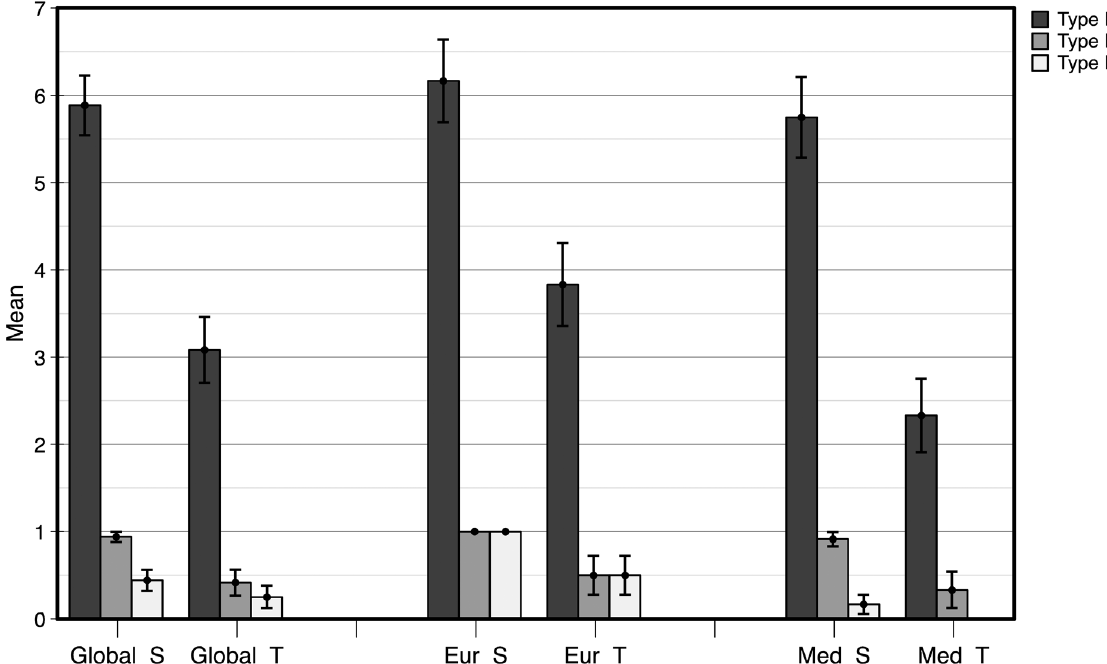
Figure 7. Mean number of species (and corresponding standard error bars) belonging to functional types I, II and III of García-Mora et al. (1999) in type S and type T dune profiles, for the overall dataset (‘Global’), in Eurosiberian areas (‘Eur’) and in Mediterranean areas